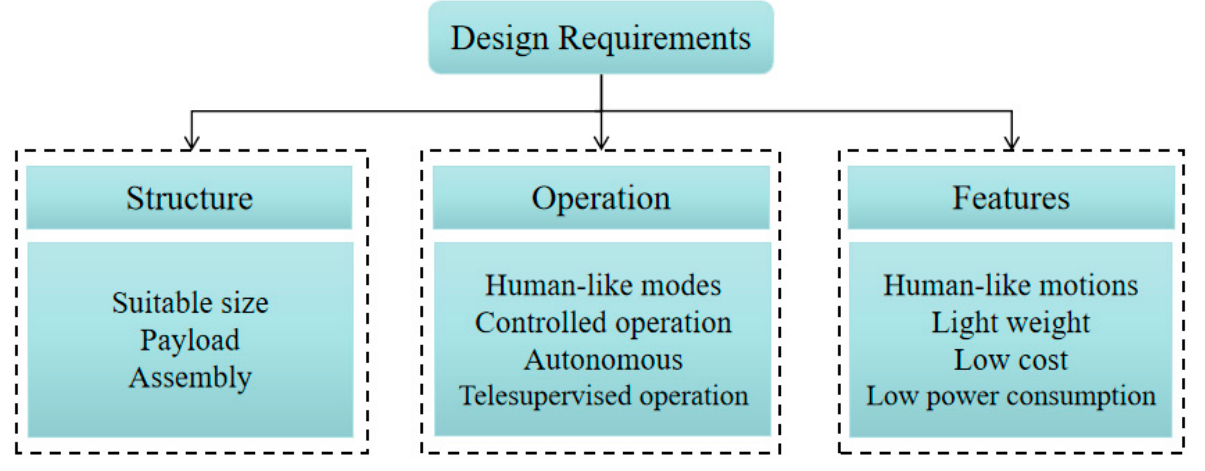
Figure 2. Design requirements of a humanoid torso.